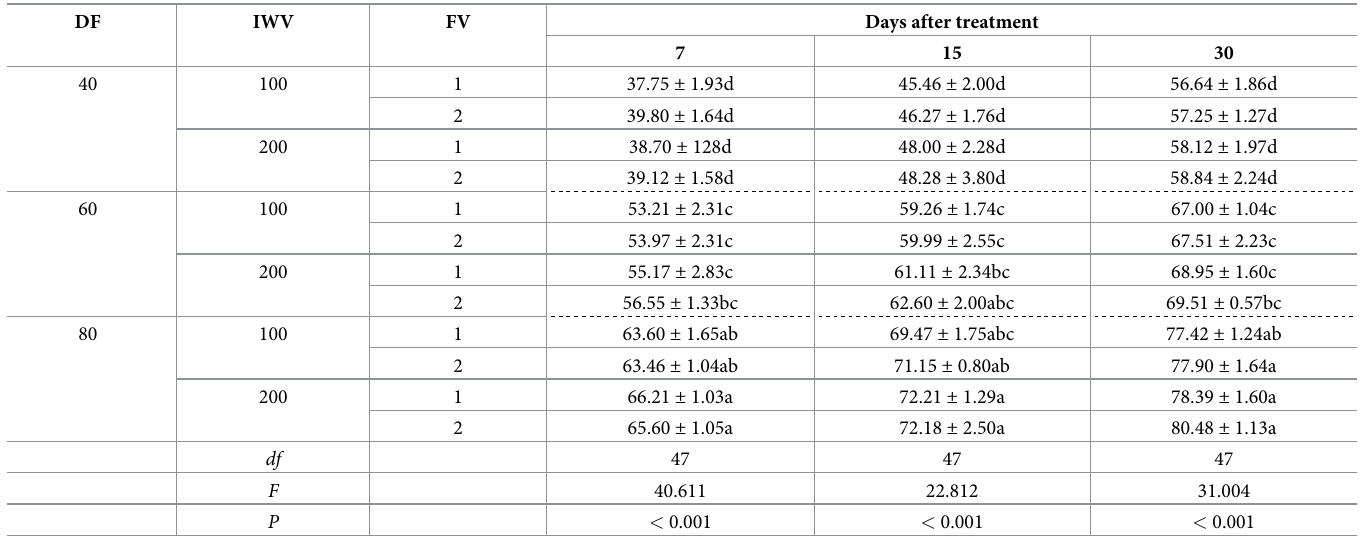
Table 2. General mortalities of fluopyram applied by chemigation to control RKN in the field. DF